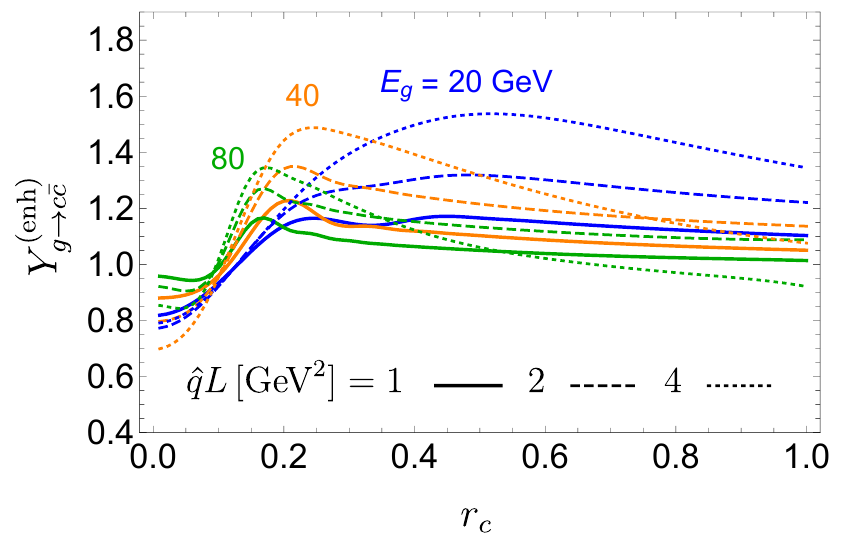
Figure 10 . The factor Y g → c ¯ c ( r c ) of (5.10) that characterises the relative enhancement of g → c ¯ c splittings into pairs with angular separation r in the QCD plasma, in the multiple soft scattering c approximation. Different colours show different gluon energies and different line styles show different values of ˆ qL